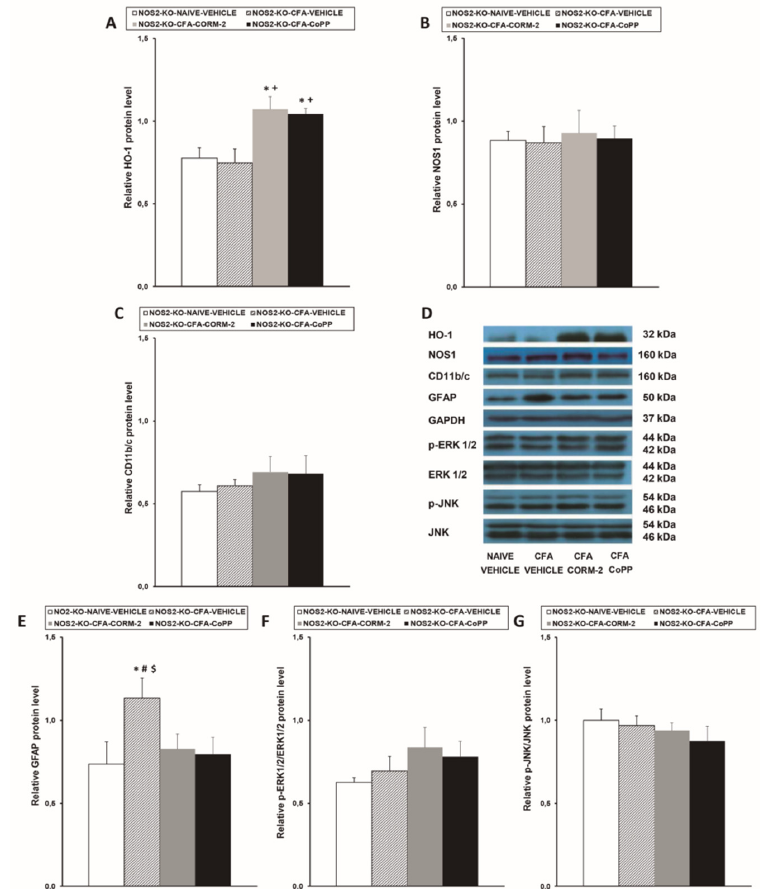
Figure 4. E ff ects of CoPP and CORM-2 on the protein levels of HO-1, NOS1, CD11b / c, GFAP, p-ERK 1 / 2, and p-JNK in the LC of NOS2-KO mice. Protein levels of HO-1 ( A ), NOS1 ( B ), CD11b / c ( C ), GFAP ( E ), p-ERK 1 / 2 ( F ), and p-JNK ( G ) in the LC of CFA-injected NOS2-KO mice treated with vehicle, CORM-2, or CoPP are represented. These levels from naïve mice treated with vehicle are also represented as controls. In all panels, * denotes significant di ff erences vs. naïve vehicle-treated mice, + represents significant di ff erences vs. CFA-injected mice treated with vehicle, # represents significant di ff erences vs. CFA-injected mice treated with CORM-2, and $ represents significant di ff erences vs. CFA-injected mice treated with CoPP ( p < 0.05, one-way ANOVA, Student–Newman–Keuls test). Examples of western blots for HO-1 (32 kDa), NOS1 (160 kDa), CD11b / c (160 kDa), GFAP (50 kDa), GAPDH (37 kDa), p-ERK 1 / 2 / total ERK 1 / 2 (42–44 kDa), and p-JNK / total JNK (46–54 kDA) are shown ( D ). The levels of phosphorylated proteins are relative to the total levels of the corresponding proteins, while the levels of the remaining proteins are relative to those of GAPDH. Each column represents the mean, and the vertical bars indicate the SEM; n = 4 samples per